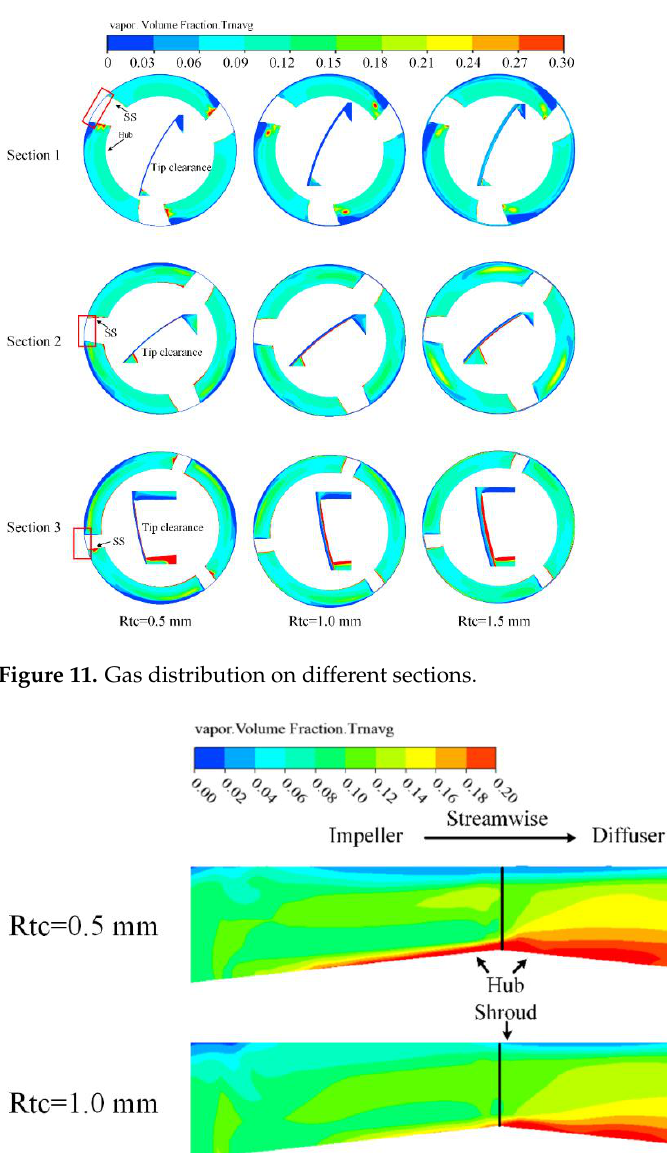
Figure 10. Sections in impeller.